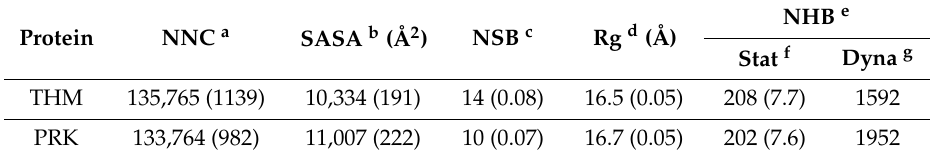
Table 2. Structural and geometrical properties (standard deviations are in parentheses) of THM and PRK during MD simulations.